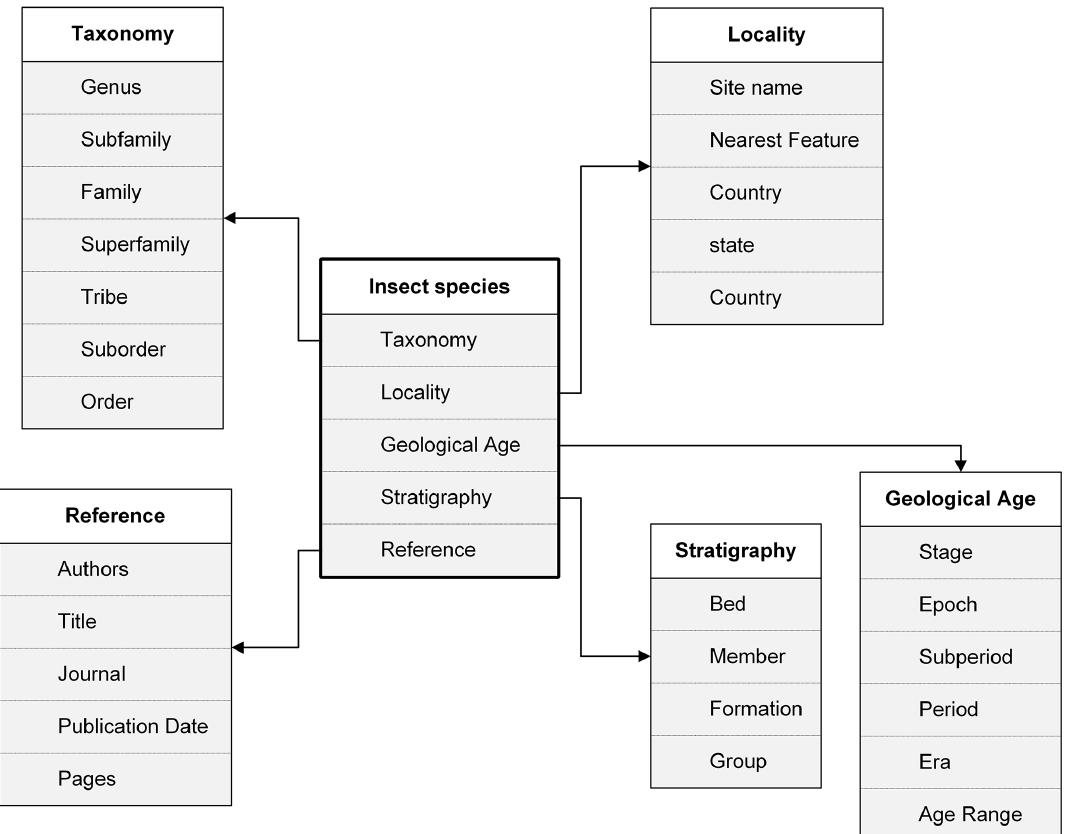
Figure 4. The data structure of the insect species name dataset of the Geobiodiversity Database (GBDB) (Xu,